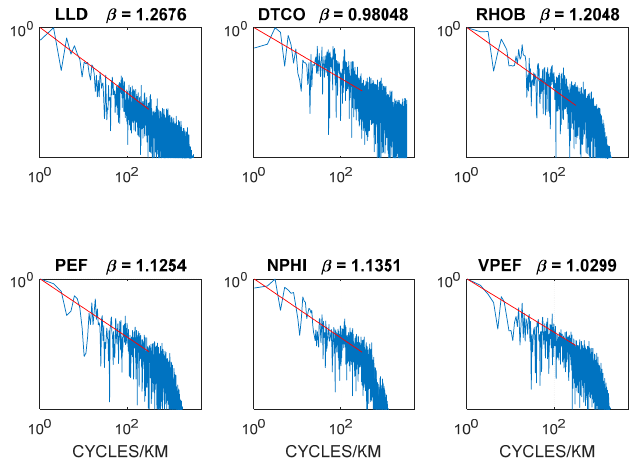
Figure 20. KTB well-log fluctuation power-spectral scaling inversely with spatial frequency, S(k) 1/k β , β ~ 1; depth 6900–8130 m; LLD = resistivity; DTCO = P-wave sonic; RHOB = mass density; PEF = photo-electric absorption; NPHI = neutron porosity; VPEF = volumetric photo-electric absorption [24].